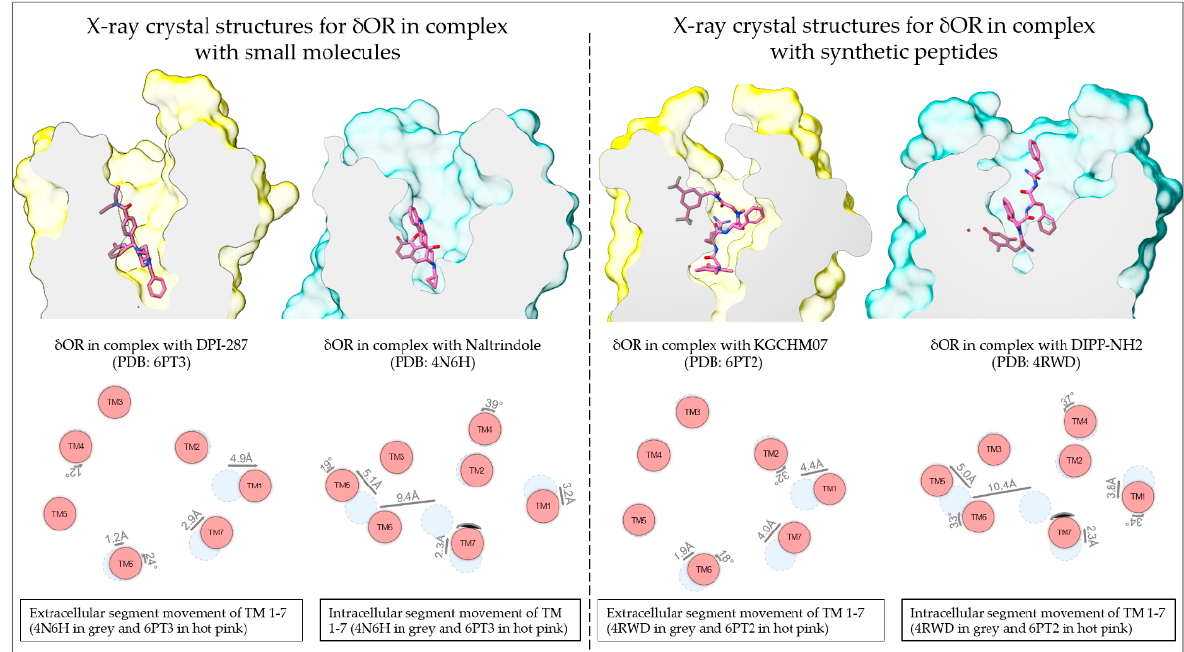
Table 1. Overview of resolved x ‐ ray crystal structures of the δ OR. Table produced using the GPCRdb.